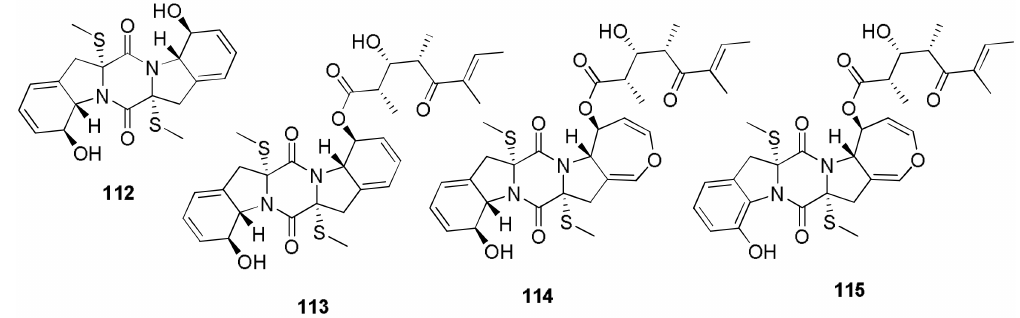
Figure 8. The structures of boydines A–D ( 112 – 115